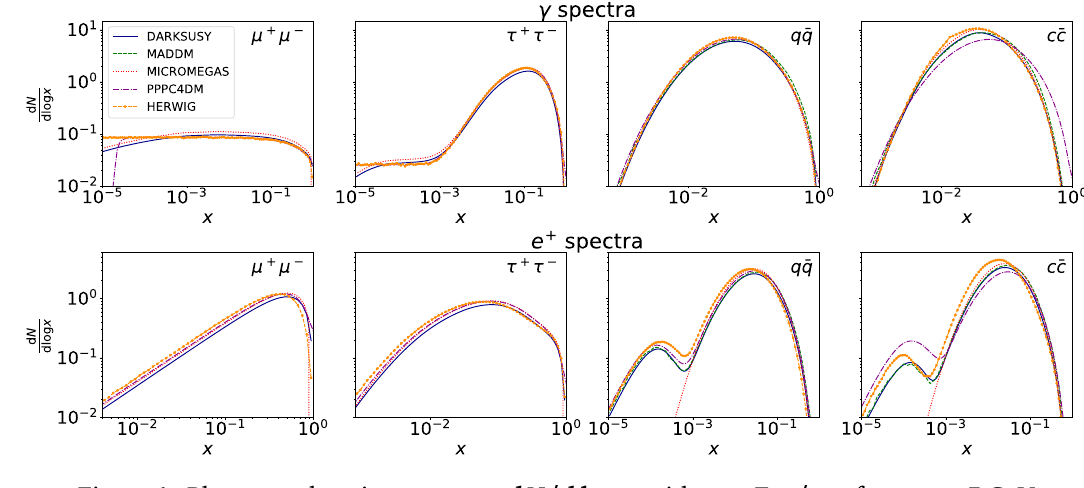
/ m = 5 GeV χ for m χ kin